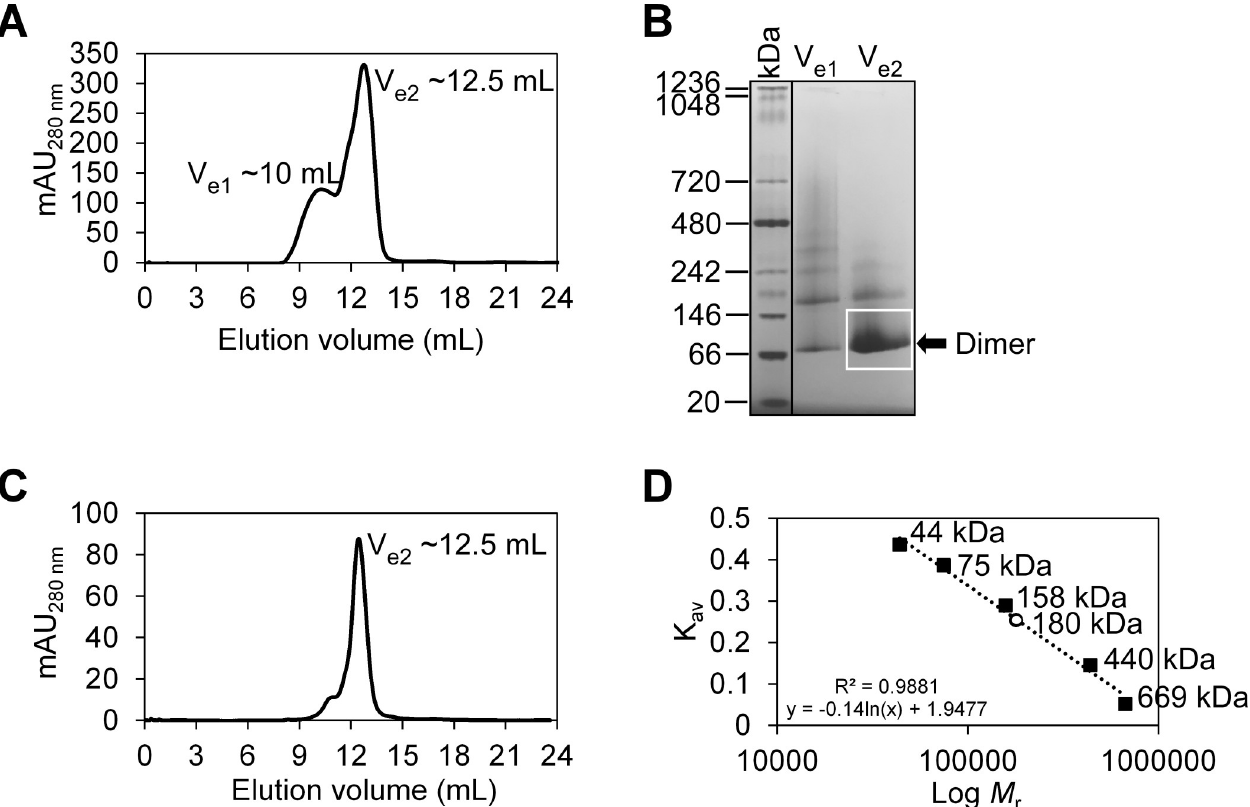
Fig 4. Assessing the oligomeric state and relative molecular weight ( M r ) of FopA. (A) Distribution of the various oligomeric states of FopA following first size exclusion chromatography (SEC). Elution peaks containing mature FopA are designated as V e1 and V e2 . (B) Clear native-PAGE of the elution peaks of the first SEC. (C) Chromatogram of a second SEC that was loaded with peak V e2 from the first SEC in A. (D) SEC column calibration using known protein standards (black squares) and calculated M r of dimeric FopA (open circle) eluted during the second SEC.